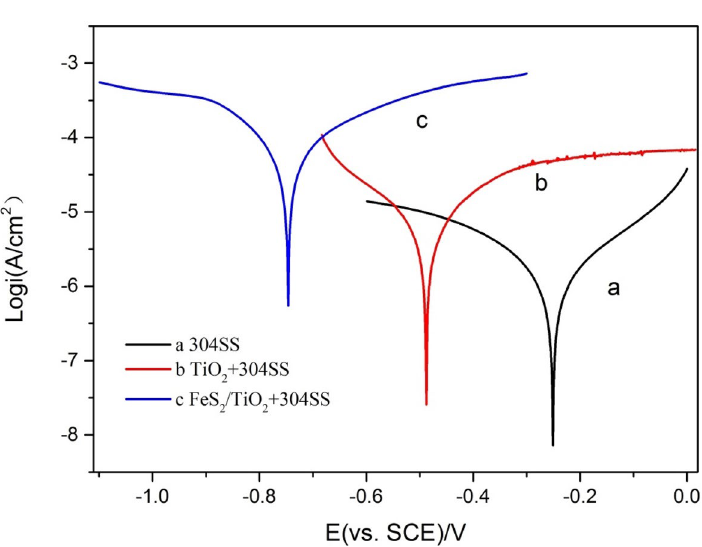
Figure 8. Tafel polarization curves of bare 304SS electrode ( a ), and 304SS coupled with pure TiO 2 ( b ) and FeS 2 / TiO 2 ( c ) under visible light